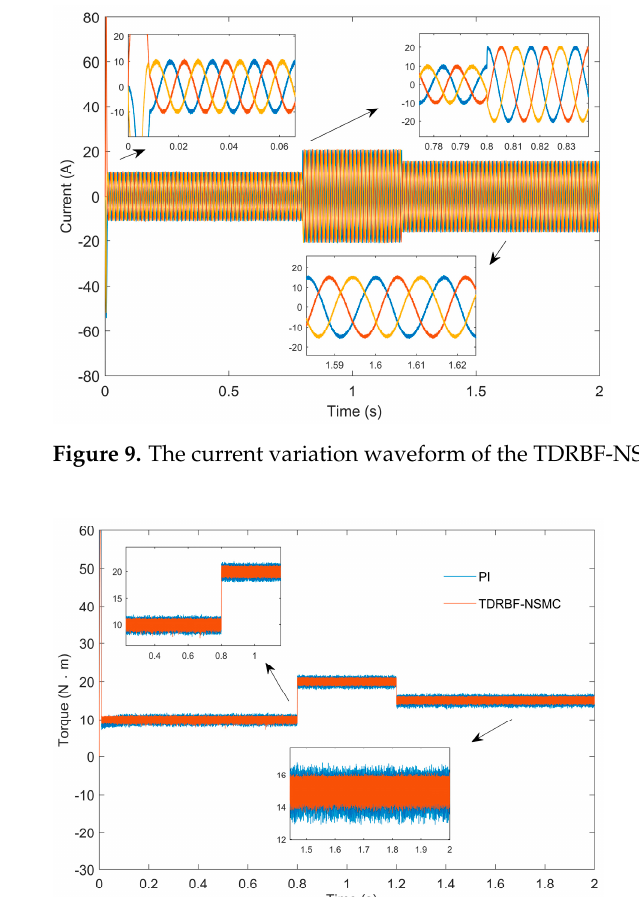
Figure 10. The torque response curves of two control algorithms.